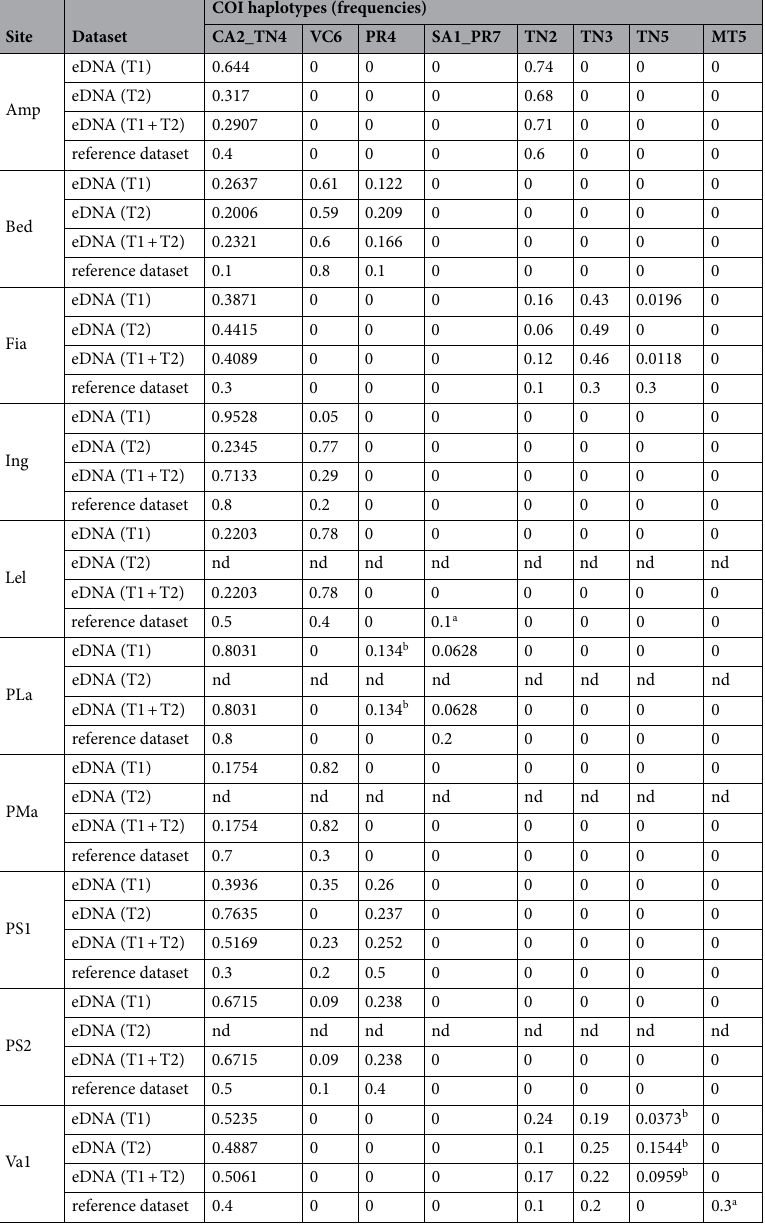
Table 2. COI haplotype frequencies for Rana temporaria populations in the Province of Trento detected by eDNA metabarcoding across temporal replicates. For each wetland site, haplotype frequencies (mean of spatial replicates S1-3) detected by eDNA metabarcoding at the different temporal points (T1, T2 and mean T1 + T2) are reported, together with available frequencies derived from traditional tissue-based genetic sampling (reference dataset: 41 ). nd = no data. a undetected by eDNA metabarcoding, but present in the reference dataset 41 ; b Detected by eDNA metabarcoding but not in the reference dataset 41